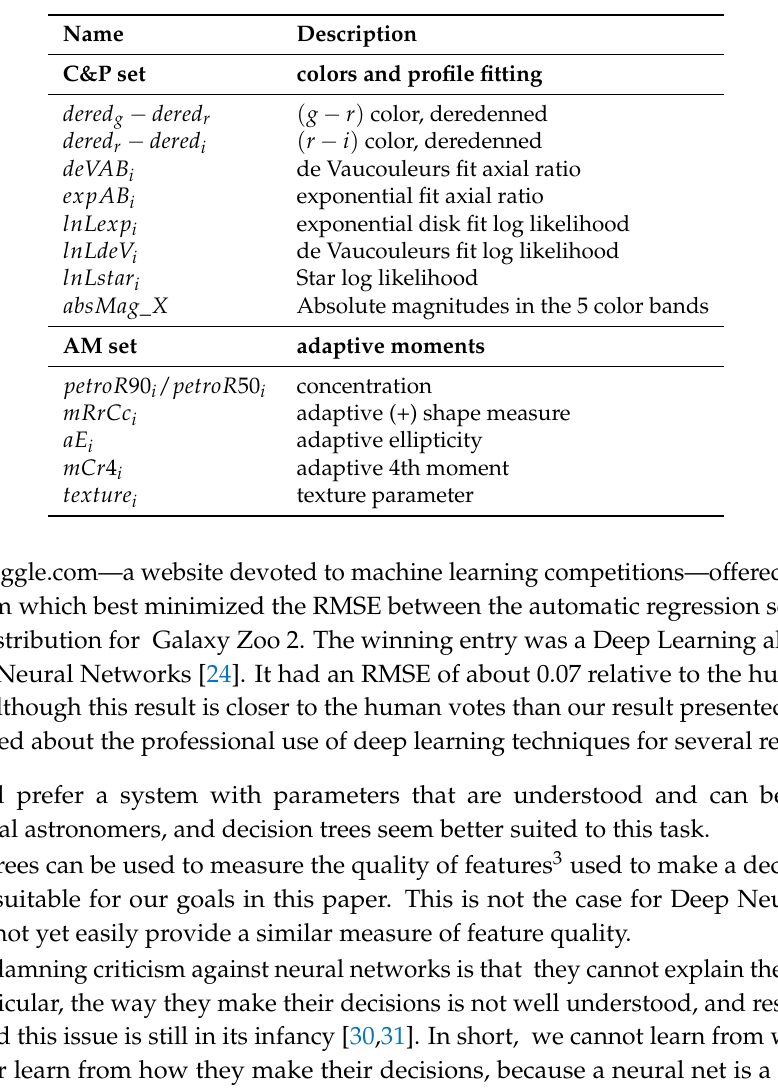
Table 1. Non-SpArcFiRe input parameters we used, identical to those used in Banerji et al. [22], except for the absolute Magnitudes that also come from Sloan Digital Sky Survey